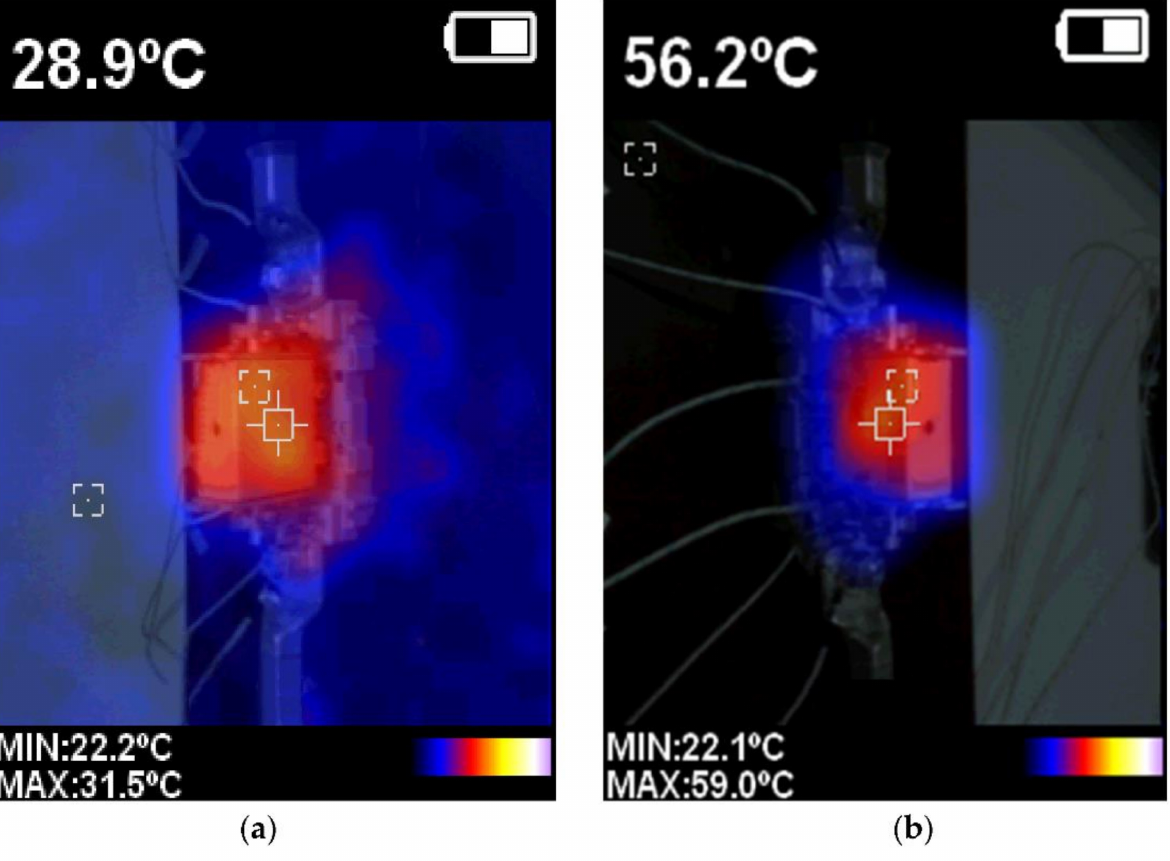
Figure 7. Screens captured from a thermal imaging camera during analysis: ( a ) after 5 min; ( b ) after maintaining the set